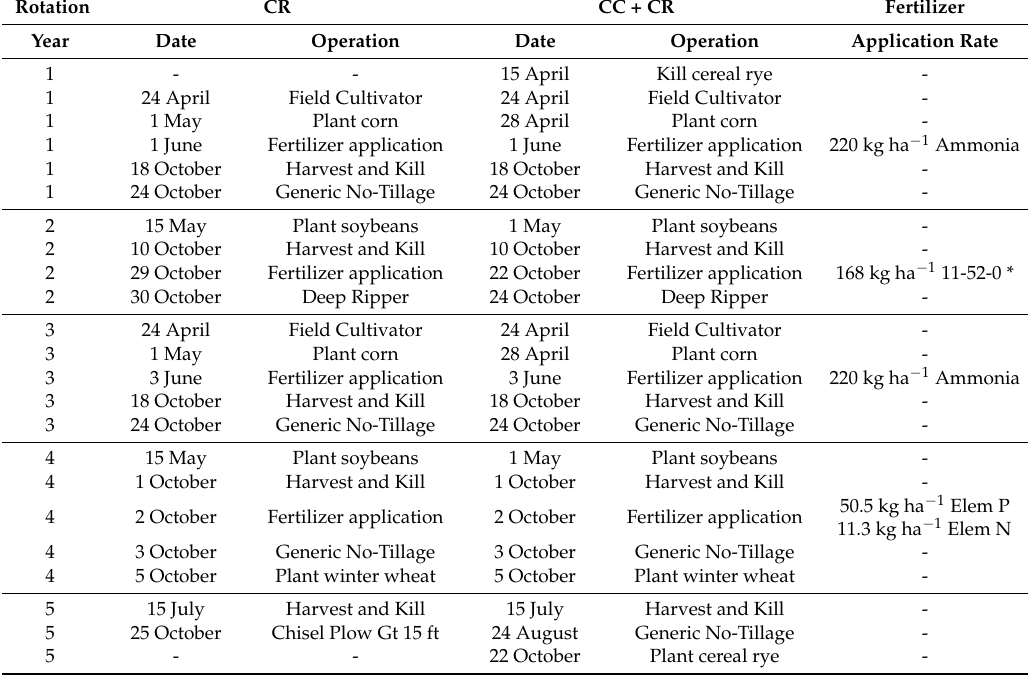
Table 2. Five-year corn, soybean, corn, soybean winter wheat (CR) and cover crop and crop rotations (CC + CR) rotations in the Eagle Creek watershed, Ohio SWAT model.